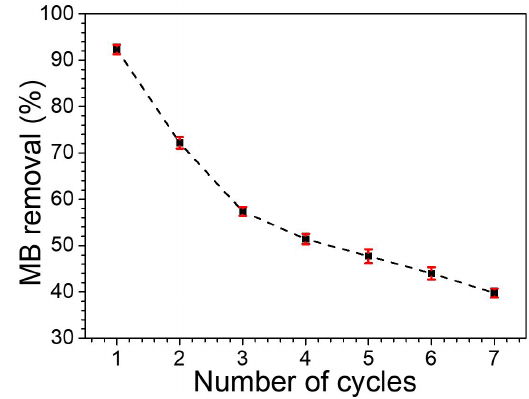
Figure 14. Evaluation of the reuse of hydrogel in the adsorption process of MB